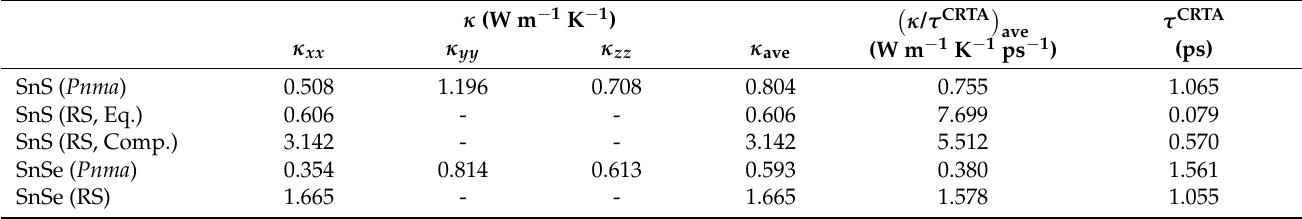
Table 2. Calculated thermal conductivities of the five structures examined in this work at T = 800 K. Each row lists the three diagonal components κ xx , κ yy , and κ zz of the κ latt tensor together with (cid:0) (cid:1) κ xx + κ yy + κ zz the diagonal average κ ave = 1 and its decomposition into harmonic and lifetime 3 (cid:0) (cid:1) κ / τ CRTA components, and τ CRTA , according to Equation (18). The data for Pnma SnS and ave